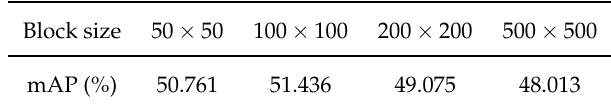
Table 3. The mean average precision (mAP) (%) of different parameters for the encrypted disorder difference histogram-based content-based image retrieval scheme (EDDH-CBIR).